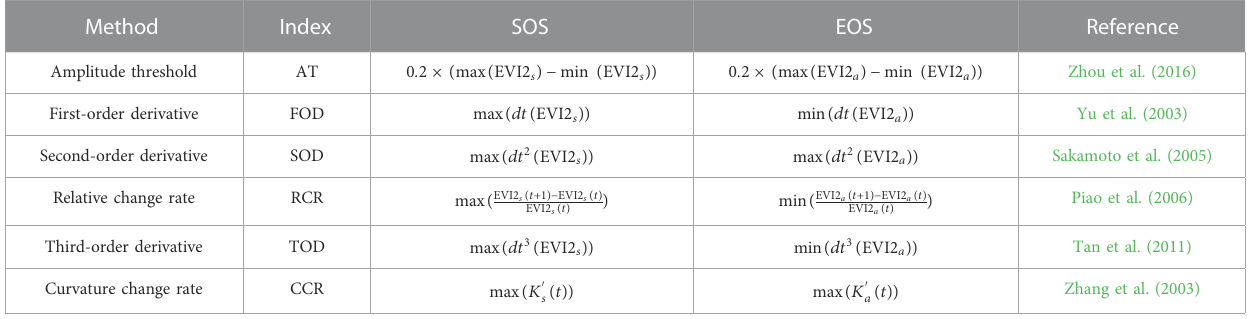
TABLE 1 Description of the six algorithms for extracting the start-of-season (SOS) and end-of-season (EOS) from the EVI2 time